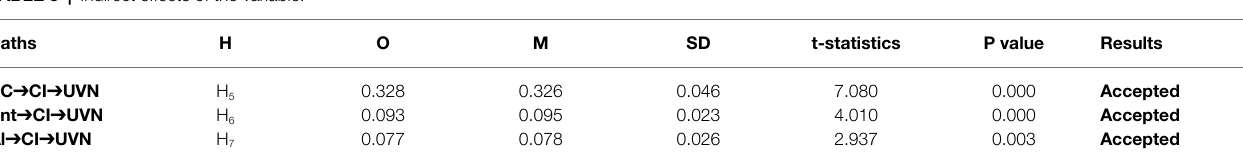
TABLE 5 | Indirect effects of the